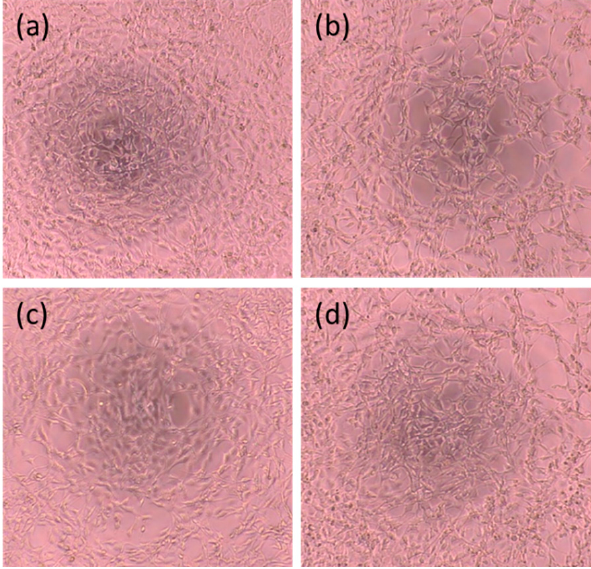
Figure 8. Morphology of NIH/3T3 cells after culturing with different periods of extraction from 2205Ag-4A for 24 h. ( a ) Control; ( b ) 1 day of extraction; ( c ) 3 days of extraction; and ( d ) 5 days of